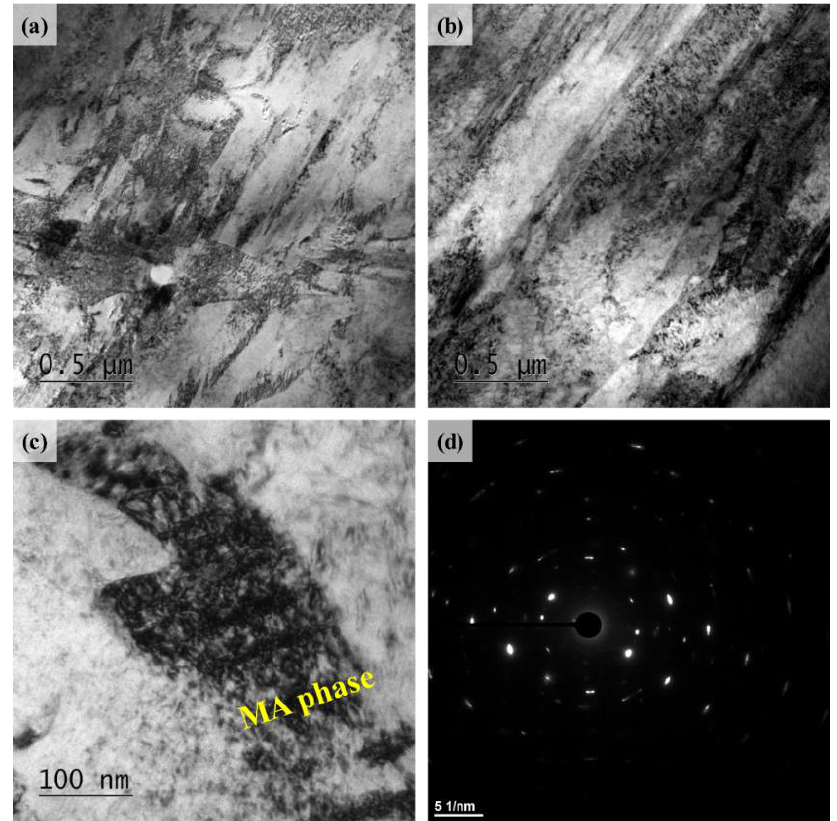
Figure 7. Bright field TEM images of the lath structure (tempered martensite & bainite) of center regions of the direct-quenched steels ( a ) alloy A, ( b ) alloy B; ( c ) bright TEM image of the martensite-austenite (MA) phase ( d ) corresponding selected area diffraction pattern (SAED) of ( c ).